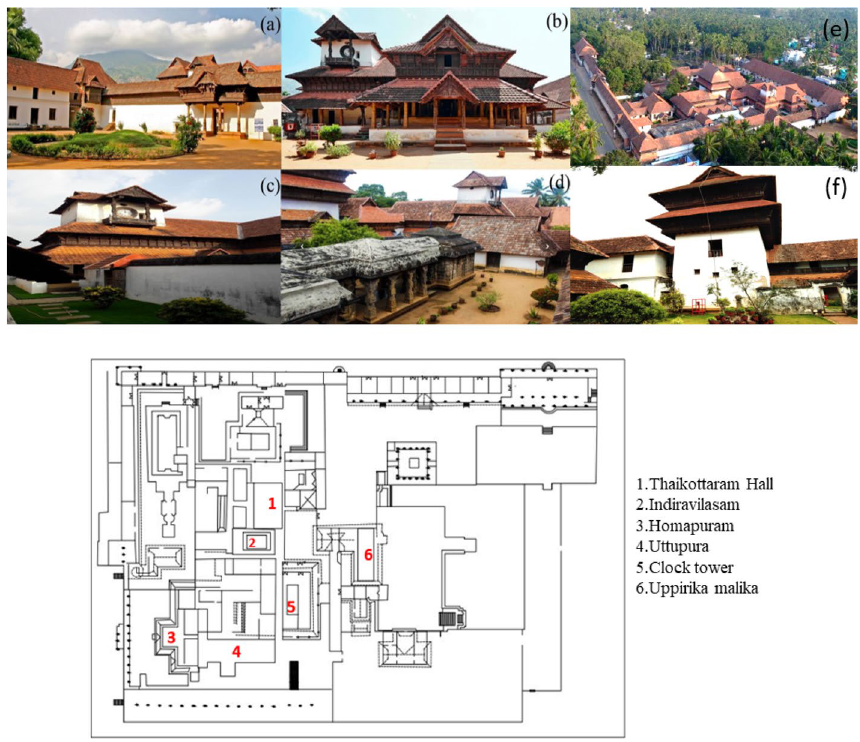
Figure 1. ( a ) Padmanabhapuram Palace plan, ( b ) Poomukha Mallika (Entrance), ( c ) Mani meda (Clock tower), ( d ) Thaikottaram hall, ( e ) Aerial view of Palace, ( f ) Uppirika